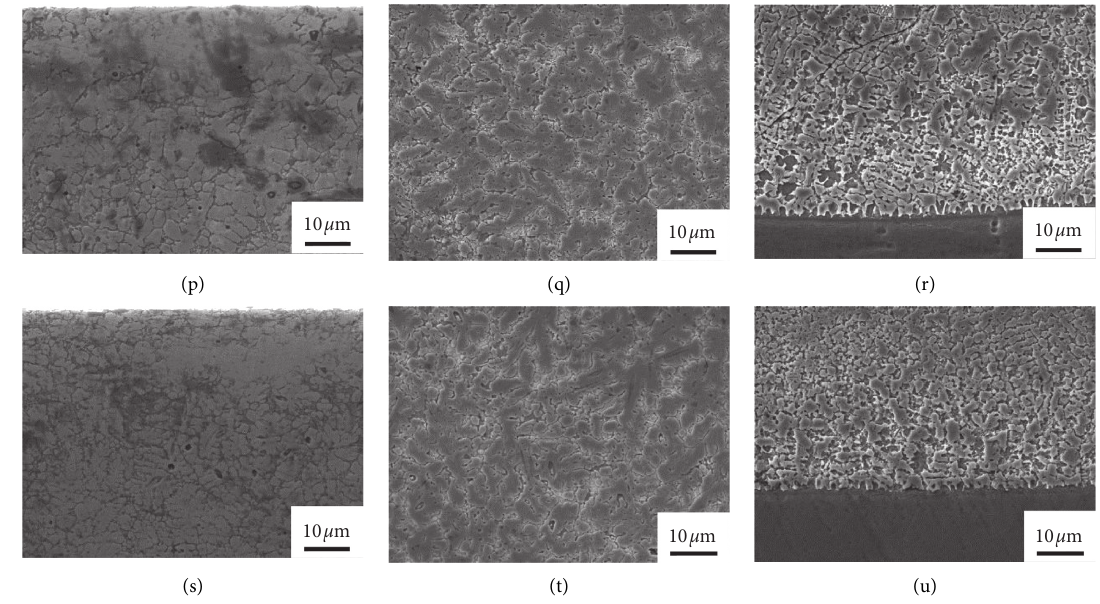
Figure 3: The SEM photographs of the laser-cladding coatings for different CeO 2 contents: (a–c) 0%, (d–f) 1%, (g–i) 2%, (j–l) 3%, (m–o) 4%, (p–r) 5%, and (s–u) 6%. (a, d, g, j, m, p, and s) The surface portion of coatings. (b, e, h, k, n, q, and t) The middle portion of coatings. (c, f, i, l, o, r, and u) The surface portion of coatings.